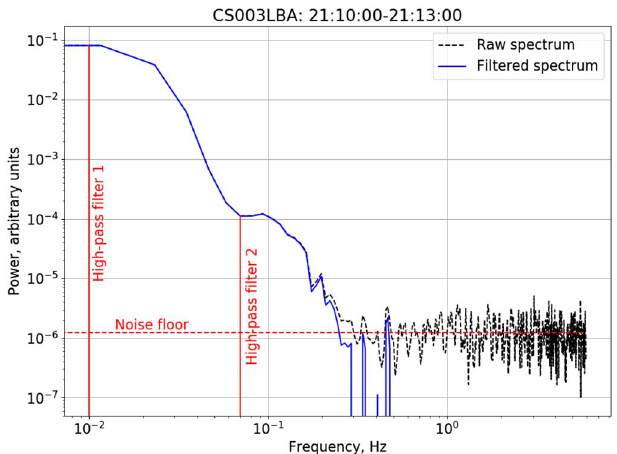
Fig. 8. Example power spectrum calculated from 3 min of intensity data received by CS003. The black curve is the raw spectrum, the blue curve is the fi ltered and noise-subtracted spectrum. The locations of the low-pass fi lter and both high-pass fi lters used are